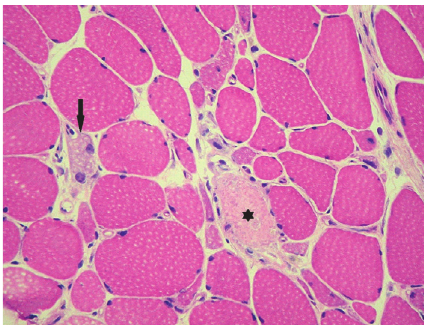
Figure 1: Muscle histology: frozen H&E stained section, showing a necrotic muscle fiber (asterisk), with marked fiber size variation and regeneration (arrow), without lymphocytic infiltration (original magnification